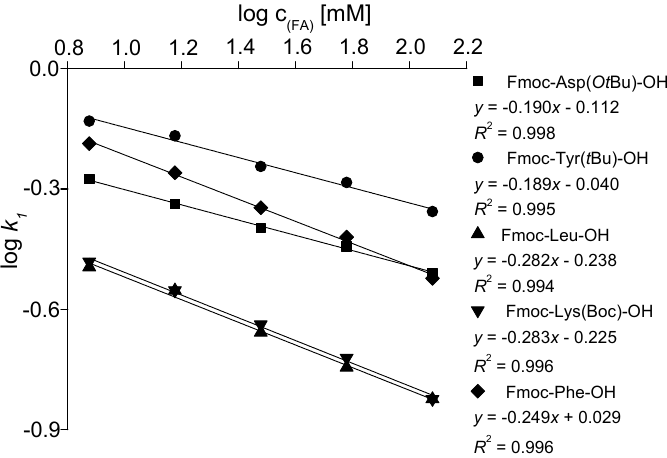
Figure 5. Effects of counter-ion concentration of selected analytes on retention factor, k